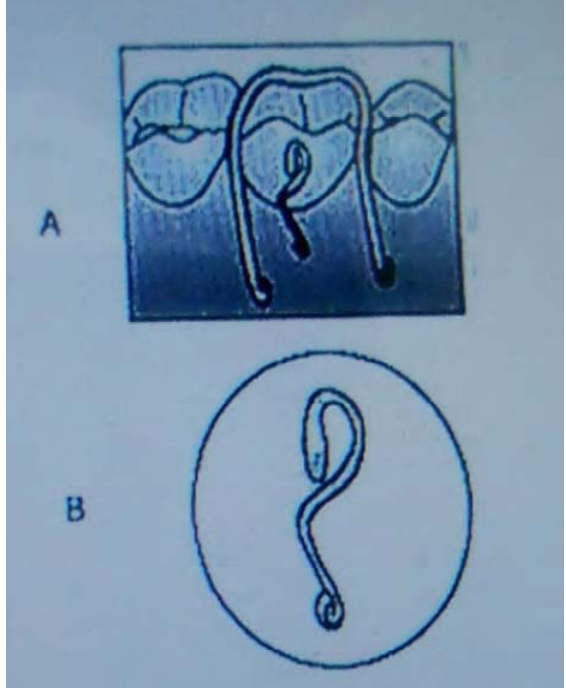
Fig. A. Visick clasp in place along with Fig. B. Close up view of Visick clasp.